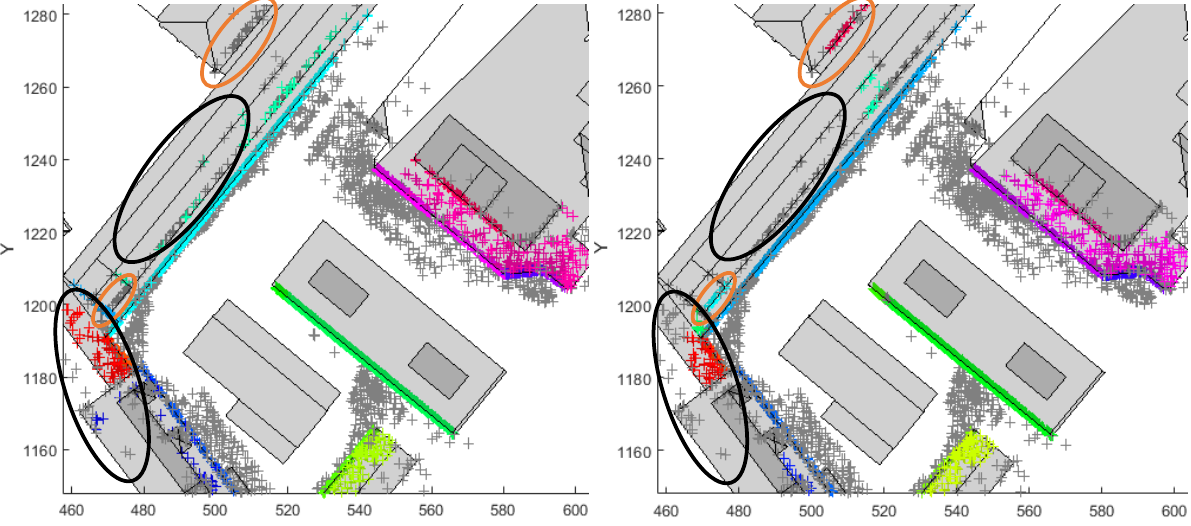
Figure 3: Estimated tie points of the hybrid adjustment with the direct (left) and the indirect (reduced) approach (right) plotted with the estimated building models in top view. Points with the same color were assigned to the same model plane. Tie points that are not matched to a plane are shown in grey. Orange ellipses highlight planes, that were found only using the indirect approach. Black ellipses denote areas, where correspondences were rejected by the indirect